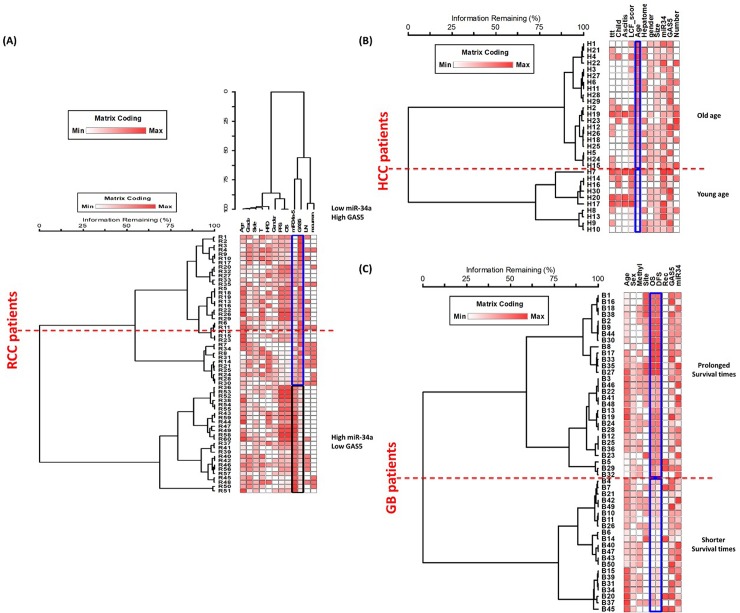
Multivariate analysis of patients according to combined transcriptomic signature of genes and clinicopathological features.(A) RCC, (B) GB, (C) HCC. RCC patients were divided based on GAS5 and miR-34a levels, GB patients were divided by survival times and HCC patients by age.